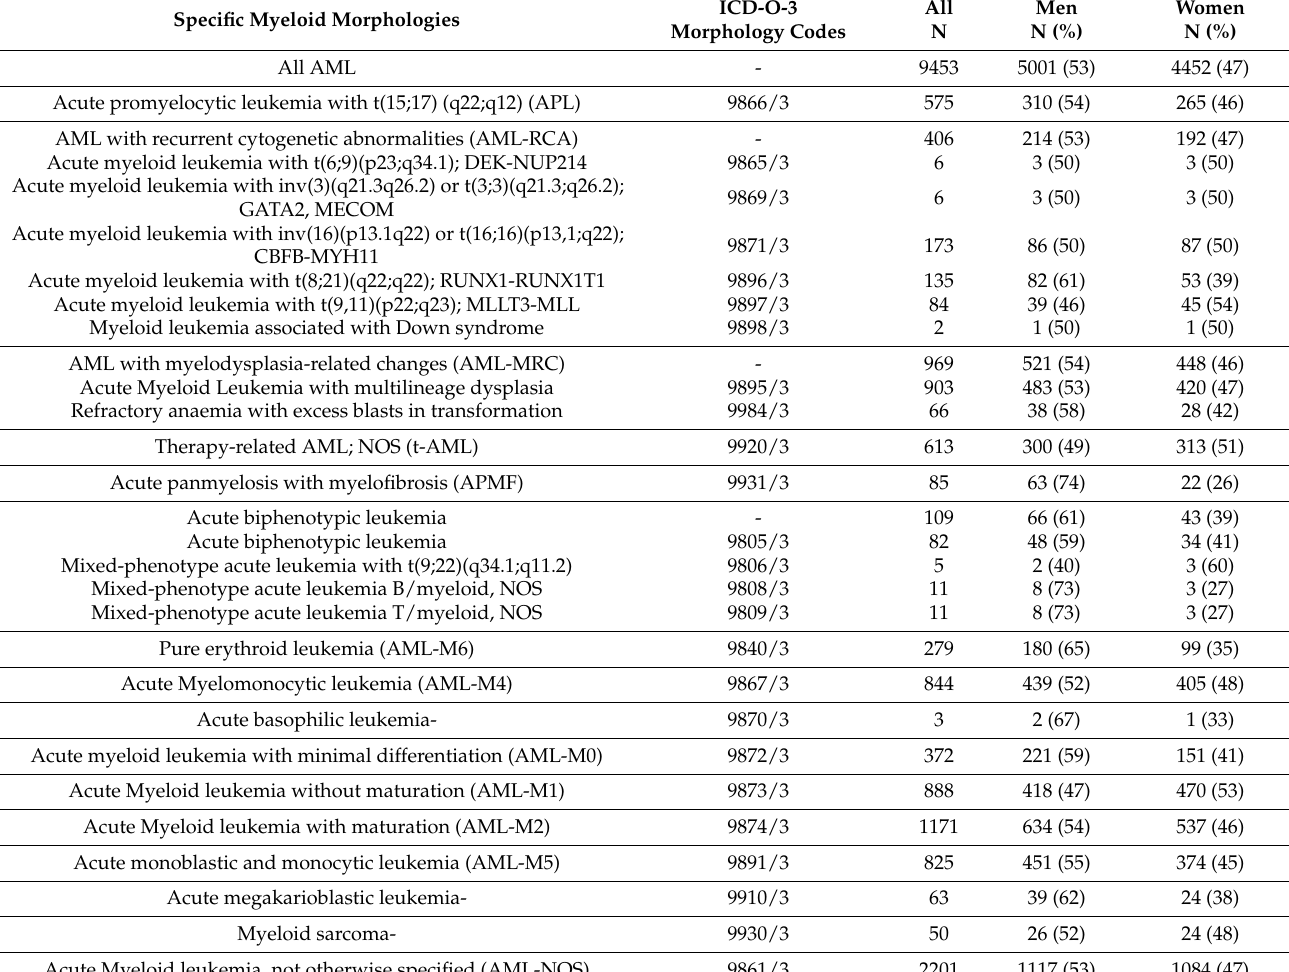
Table 1. Classification of Acute Myeloid Leukaemia (AML) according to the Haemacare Study Group proposal as regards to their morphology (ICD-O-3 codes) and numbers of cases in our 9 453 AML patients over period of diagnosis from 1995 to